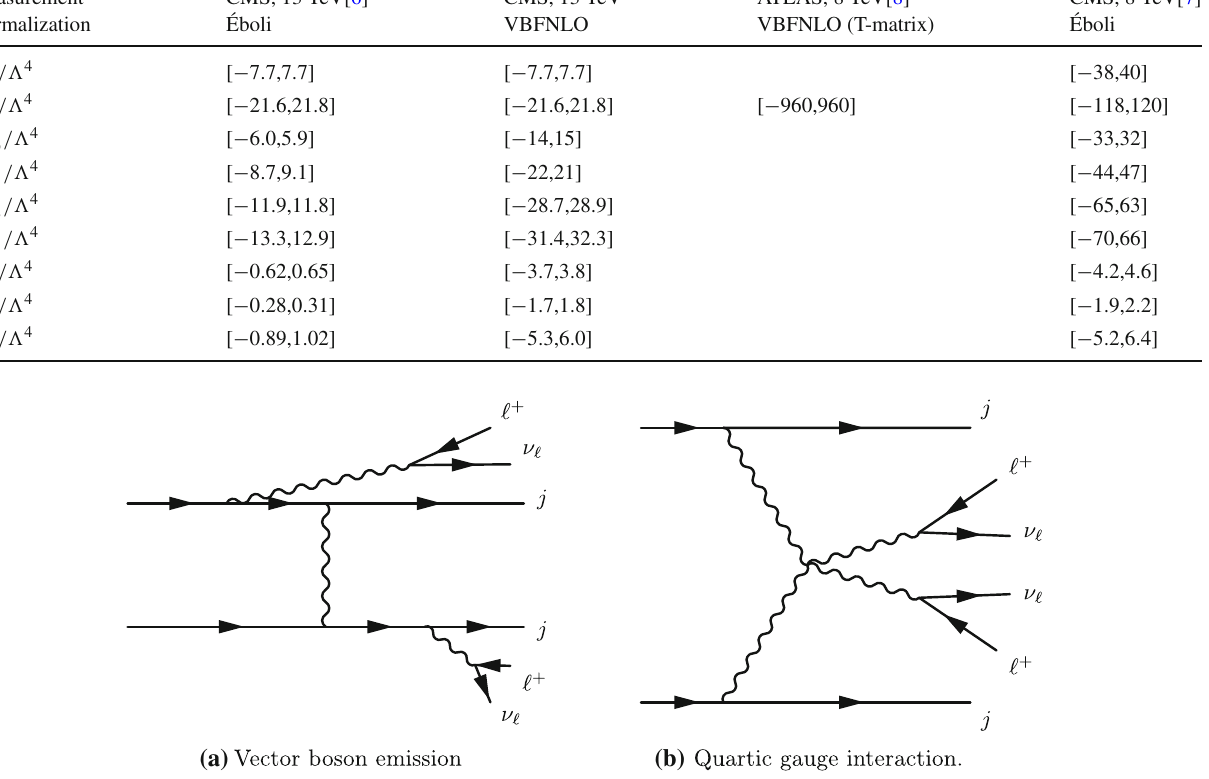
Table 1 Experimental limits (in TeV − 4 ) on the coefficients of dimension-8 operators, f i /(cid:2) 4 , from observation of pp → W ± W ± jjX Measurement